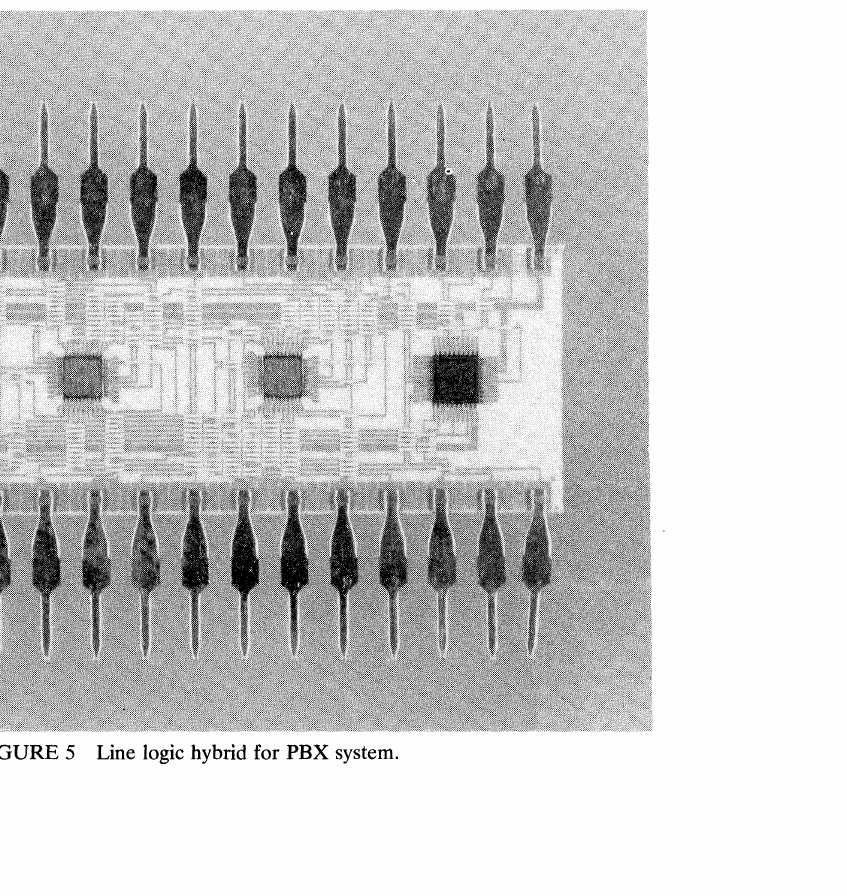
FIGURE 4 Precision RC circuit used in a transmission system.